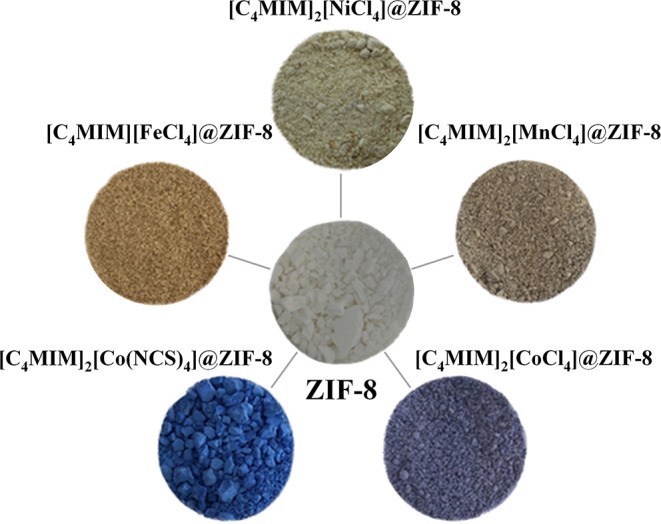
Samples of ZIF-8 and produced magIL@ZIF-8 powdered materials.